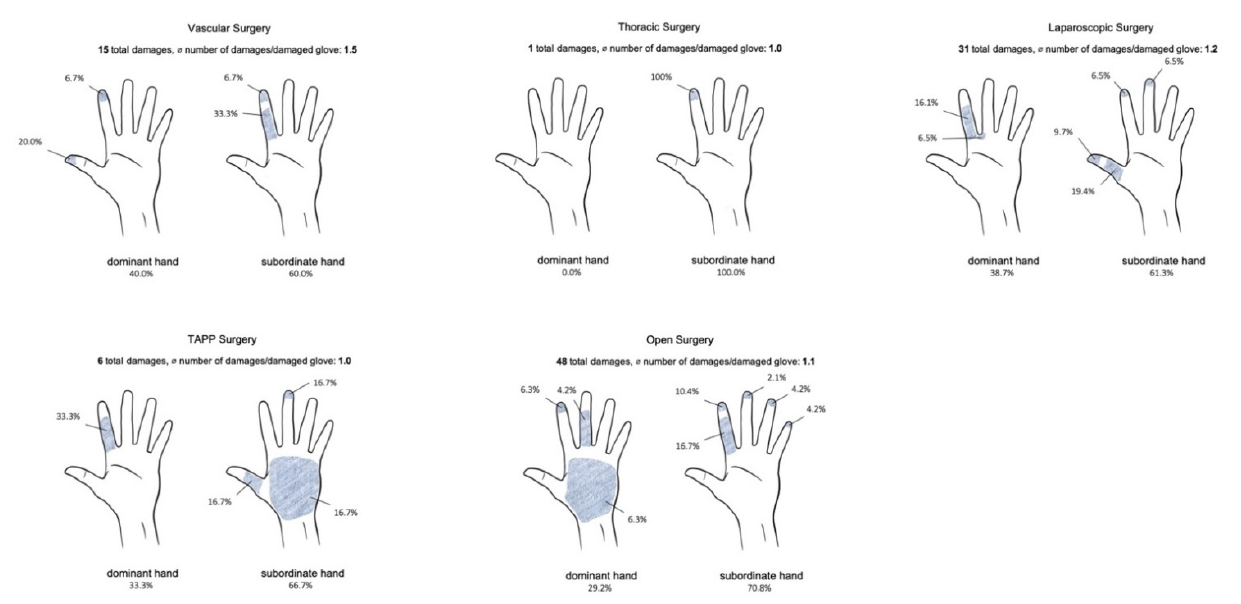
Figure 1. Distributions of damages with frequencies in % and number of damages per damaged glove according to investigated group of surgery.